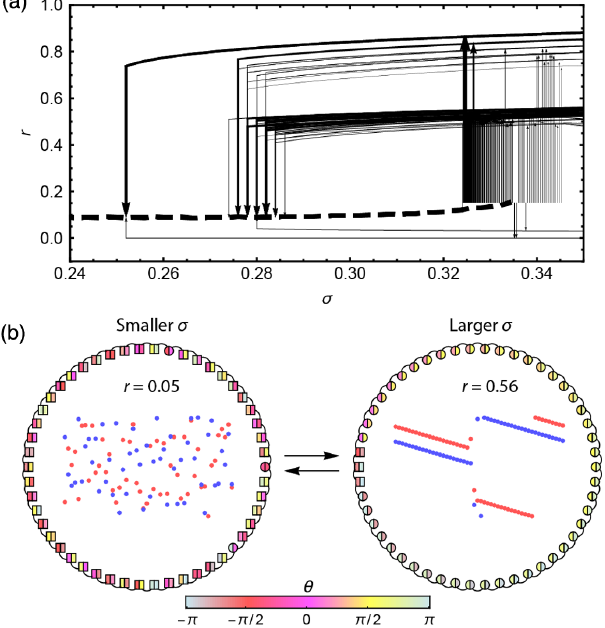
FIG. 6. Transitions to and from the asynchronous branch under quasistatic variations in the coupling strength. (a) Hysteresis curves around the asynchronous solution branch (thick dashed line), with transition probabilities indicated by the arrow thick- ness. (b) Example transitions to and from the asynchronous branch. The circles (squares) depict phase-locked (asynchronous) Janus oscillators, and their colors show the instantaneous phases. An inset of the phases as plotted in Fig. 5 is shown in the center of the ring.